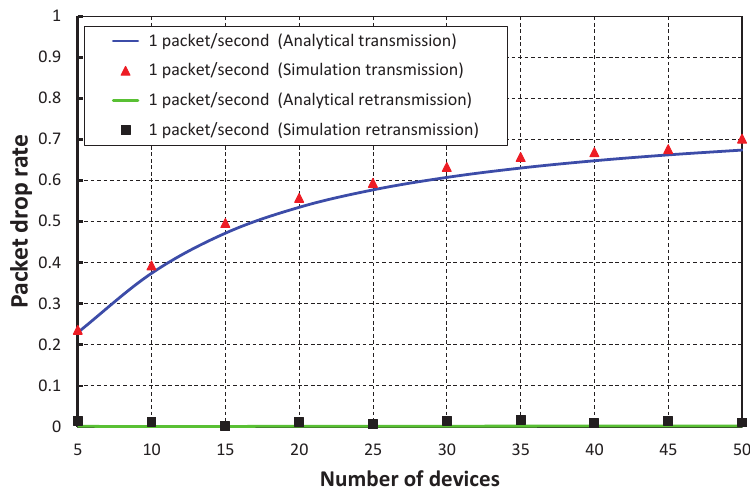
Figure 17. Validation of the packet drop rate of our proposed scheme for different numbers of devices.